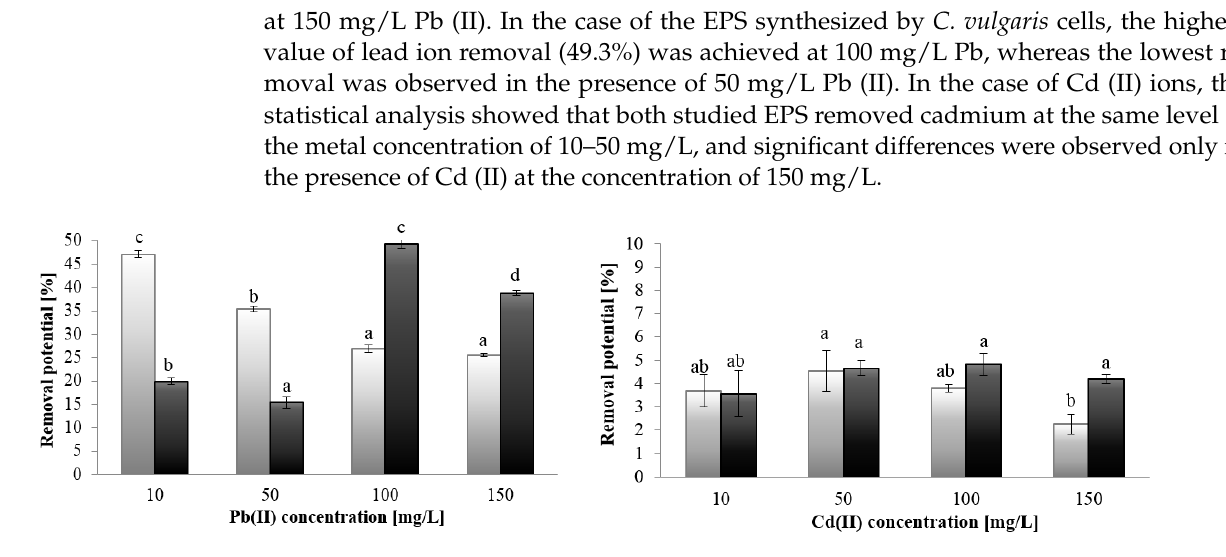
Figure 1. Removal potential of EPS from P. kessleri (light grey bars) and C. vulgaris (dark grey bars) towards Pb (II) and Cd (II). The letters (a, ab, b, c, d) on the graphs indicate statistical significance of the presented results analyzed by Tukey test ( p ≥ 0.05).